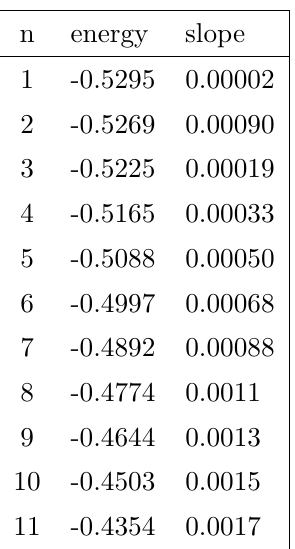
Table 3 . Numerical values for eigenvalues and slopes, with (cid:12)xed coupling, using the Wilsonian IR regulator.